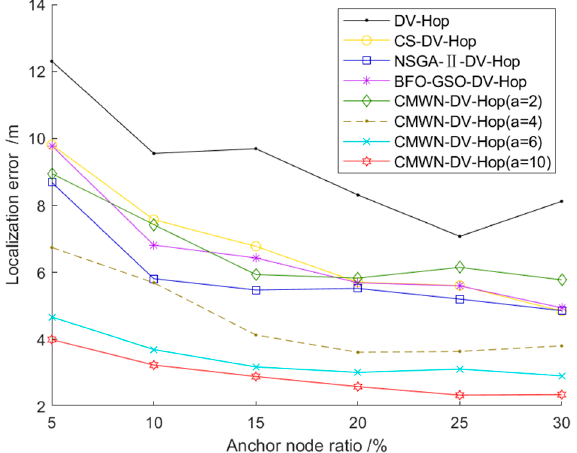
Figure 10. Comparison of various localization algorithms with different anchor node ratio: localiza- tion error.